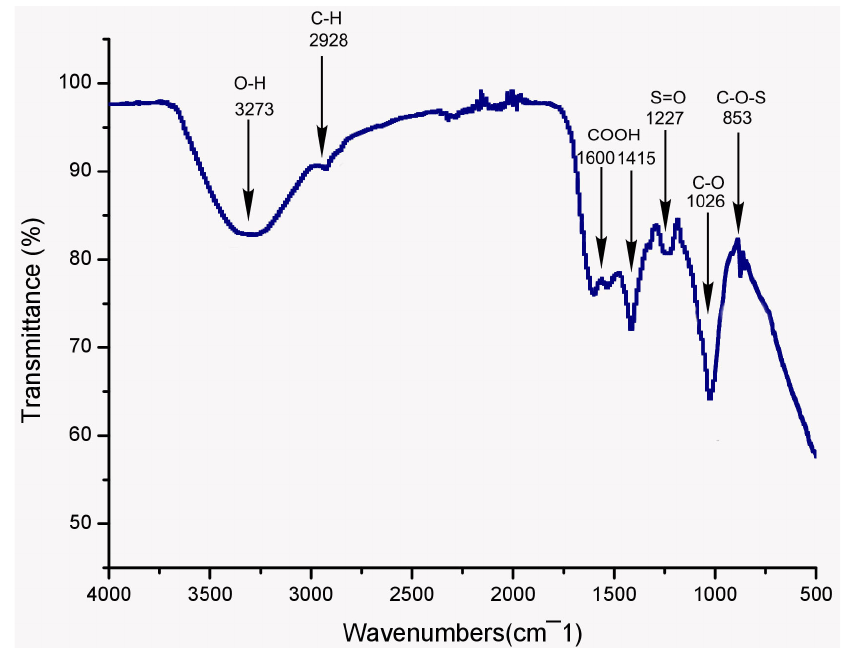
Figure 2. IR spectrum of the polysaccharide